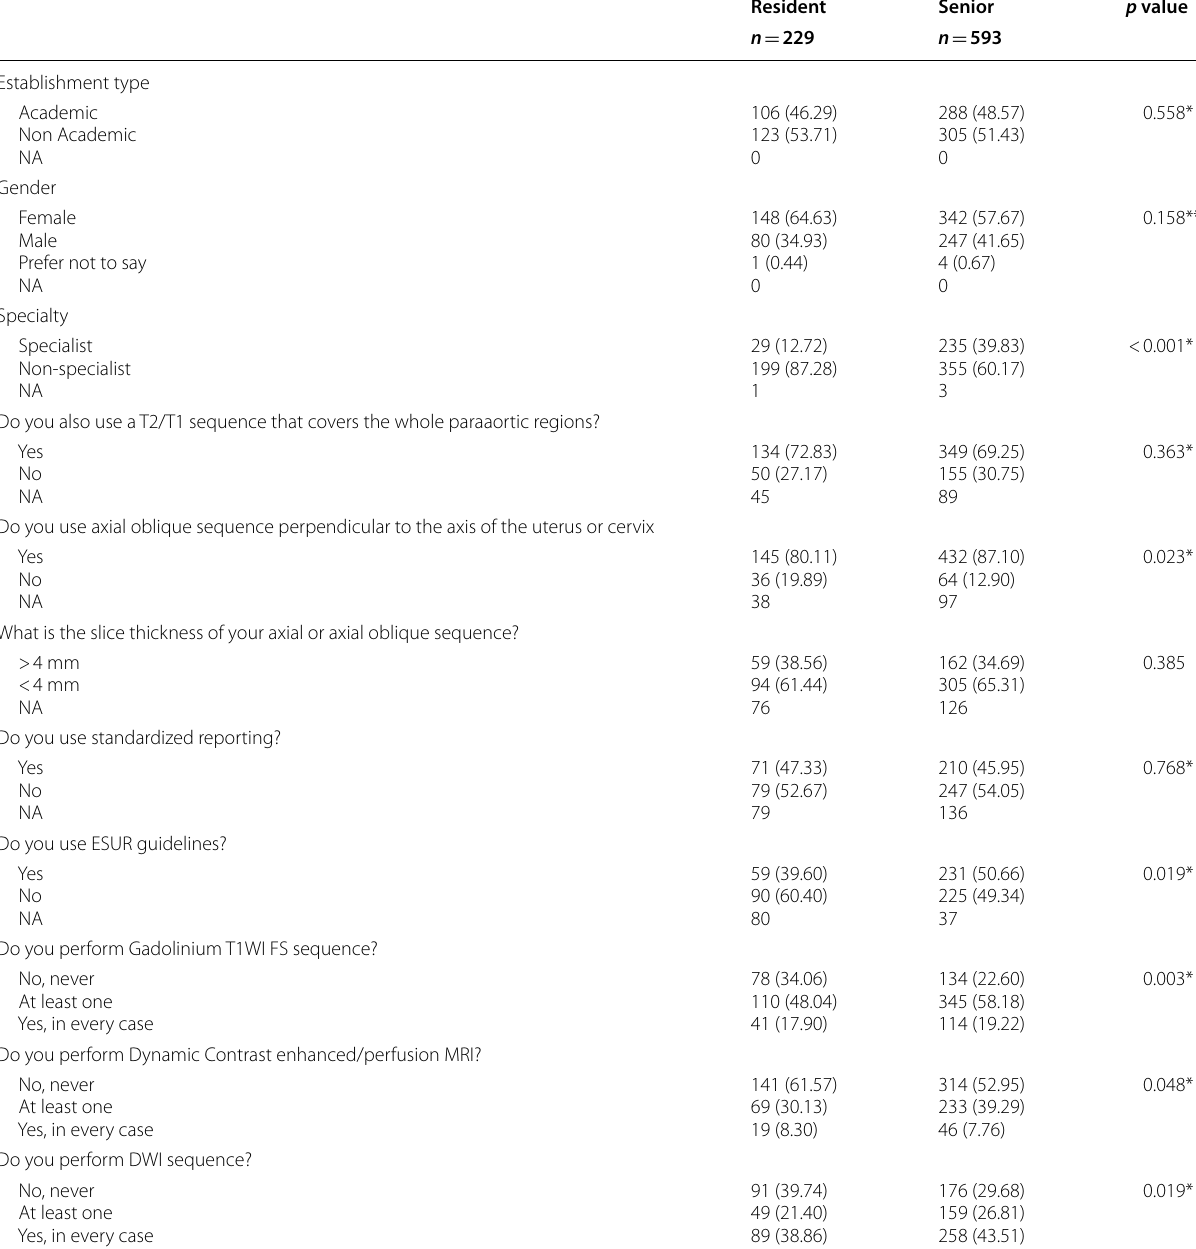
Table 5 Subgroup analysis regarding Radiology